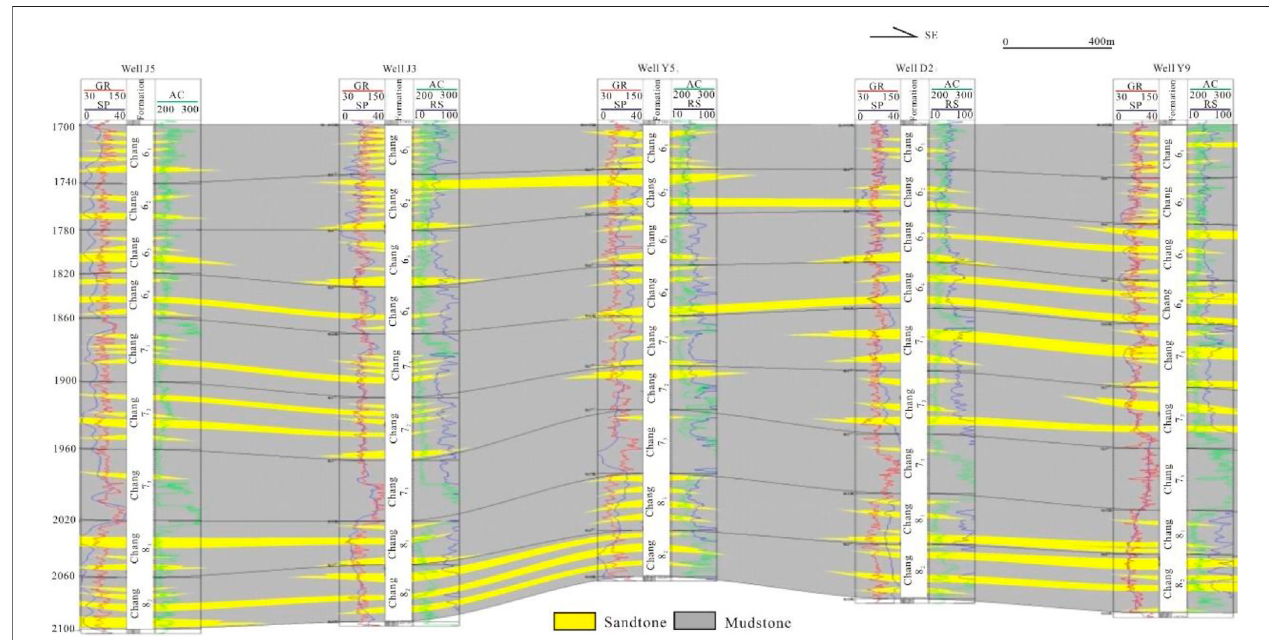
FIGURE 2 | The stratigraphic well-connected pro fi le of the Chang 6 to Chang 8 Members of the Yanchang Formation through the J5-Y9 wells in the study area.